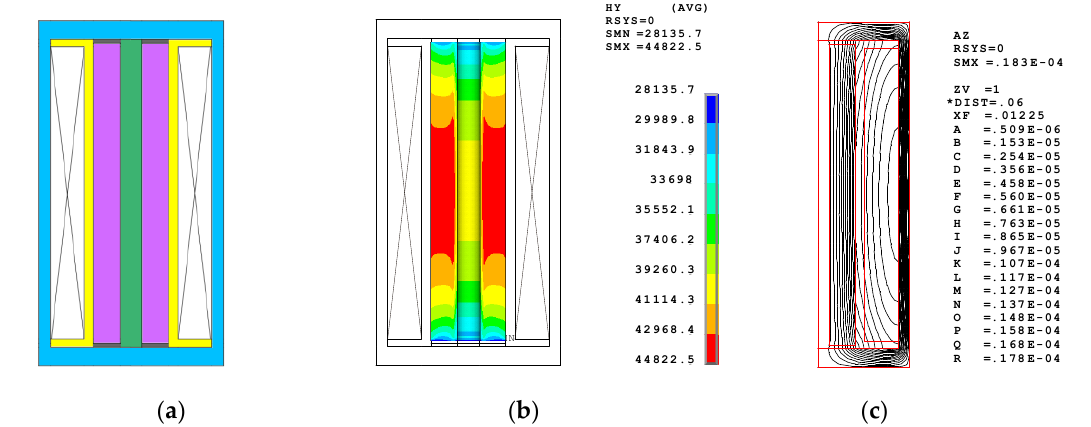
Figure 6. DC driving coil configuration and the finite element simulation. ( a ) The configuration; ( b ) the Bias Magnetic Field Intensity (MFI) distribution; ( c ) the Flux distribution.